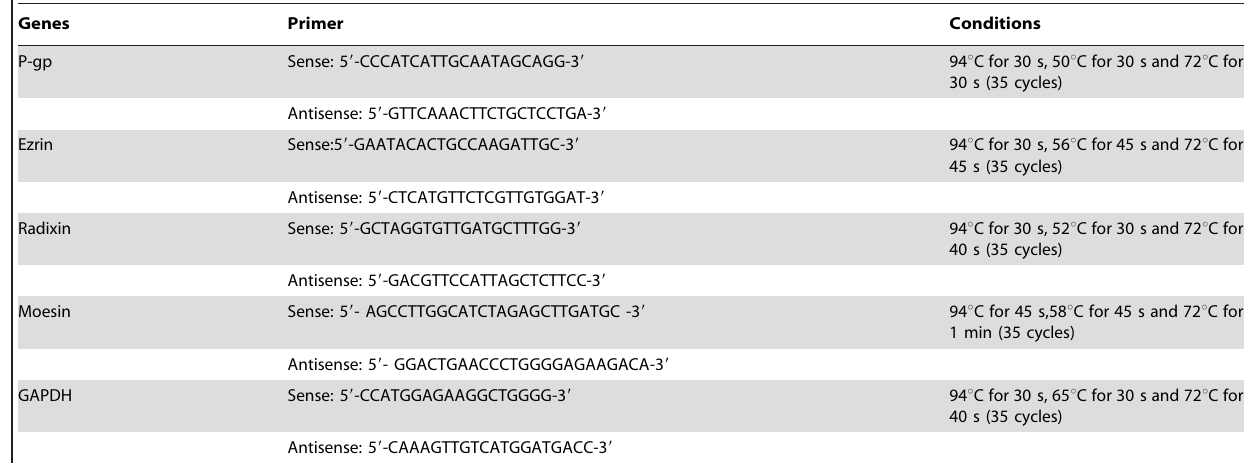
Table 1. Primer sequences and RT-PCR conditions.